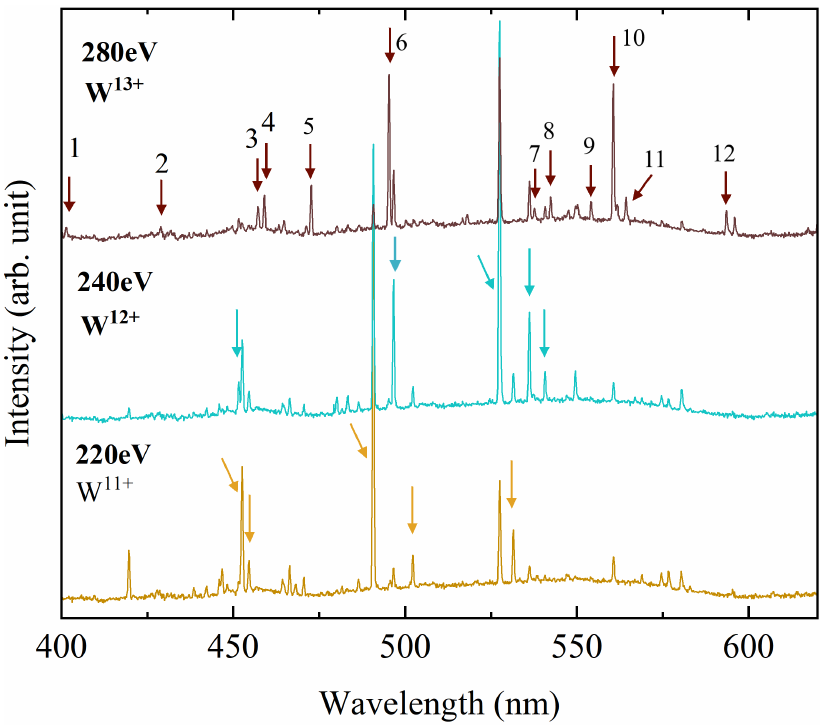
Figure 1. Experimental spectra observed at various electron energies. W 13 + lines are shown by arrows with numbers at 280 eV.